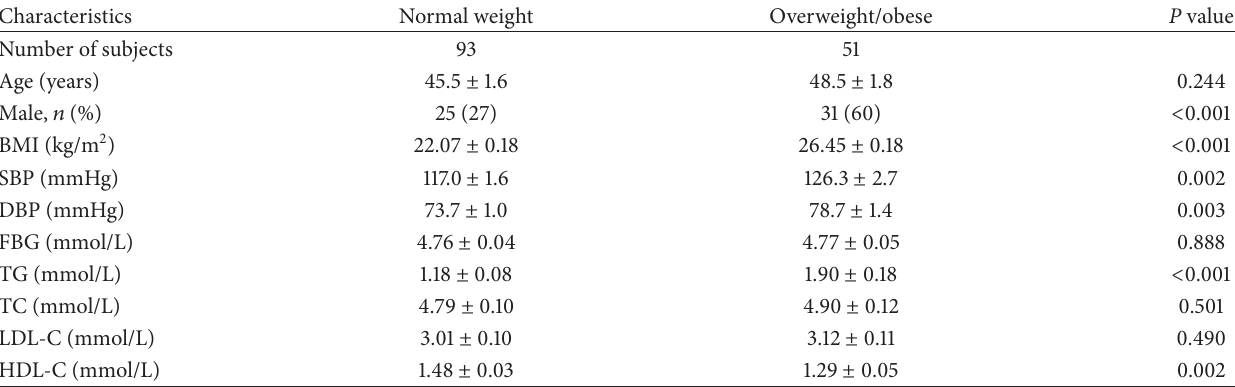
Table 2: Clinical and biochemical characteristics of the study subjects.